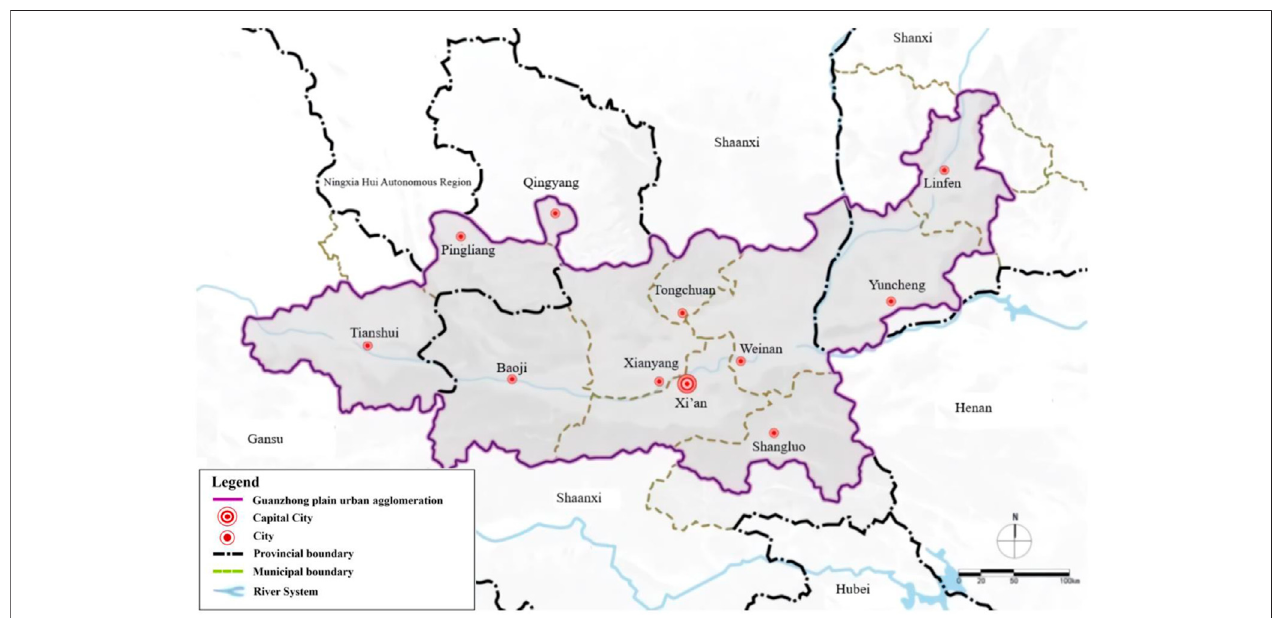
FIGURE 2 | Planning scope of Guanzhong Plain urban agglomeration. Source: Guanzhong Plains Urban Agglomeration Development Plan.